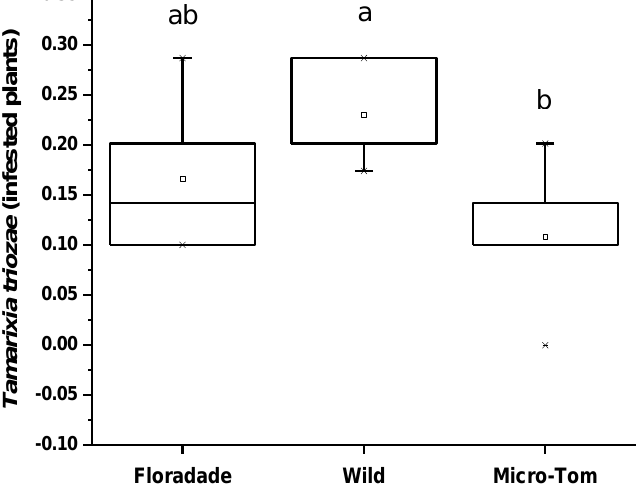
Figure 3. Average number of T. triozae adults attracted toward infested plants with N3 nymphs of B. cockerelli in different tomato varieties (Floradade, Wild, and Micro-Tom). Different letters indicate statistical differences ( p < 0.05).